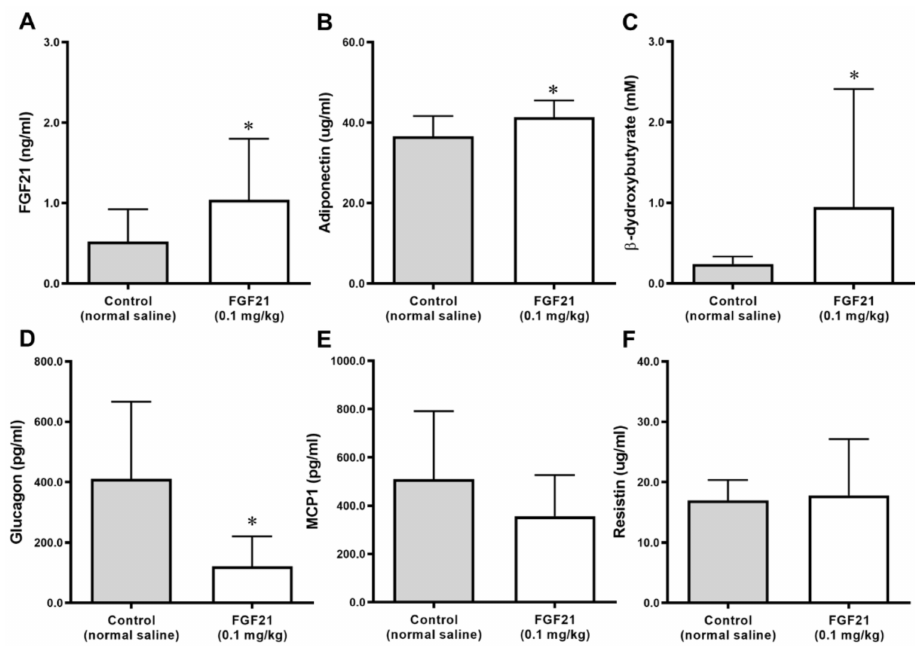
Figure 3. Changes in FGF21 ( A ), adiponectin ( B ), β -hydroxybutyrate ( C ), glucagon ( D ), monocyte chemoattractant protein-1 (MCP1) ( E ), and resistin ( F ) levels after 5 weeks of treatment with normal saline as a control and fibroblast growth factor 21 (FGF21; 0.1 mg / kg) in ApoE − / − mice. Data are means ± SD. * p < 0.05 vs.